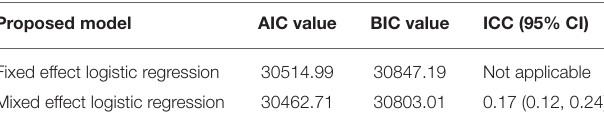
TABLE 2 | Sociodemographic characteristics of respondents for the study on magnitudes of anemia and its determinant factors among lactating mothers in East African countries,